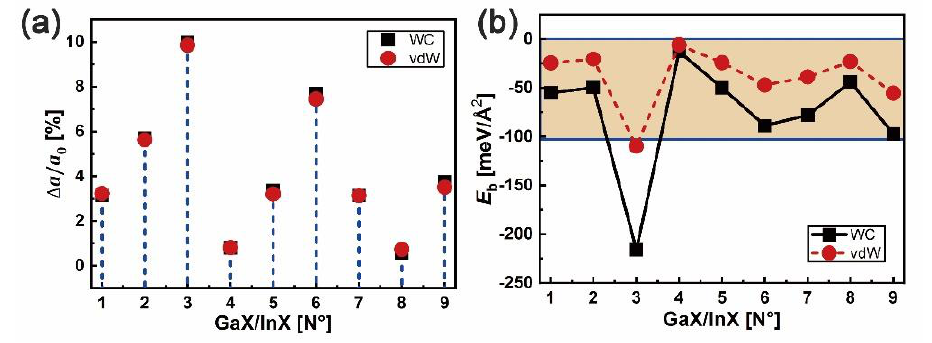
Figure 5. In-plane lattice mismatch ∆ a / a 0 in %: ( a ) and binding energy E b in meV / Å 2 , and ( b ) at the GaX / InX (X = S, Se, Te) heterointerface.